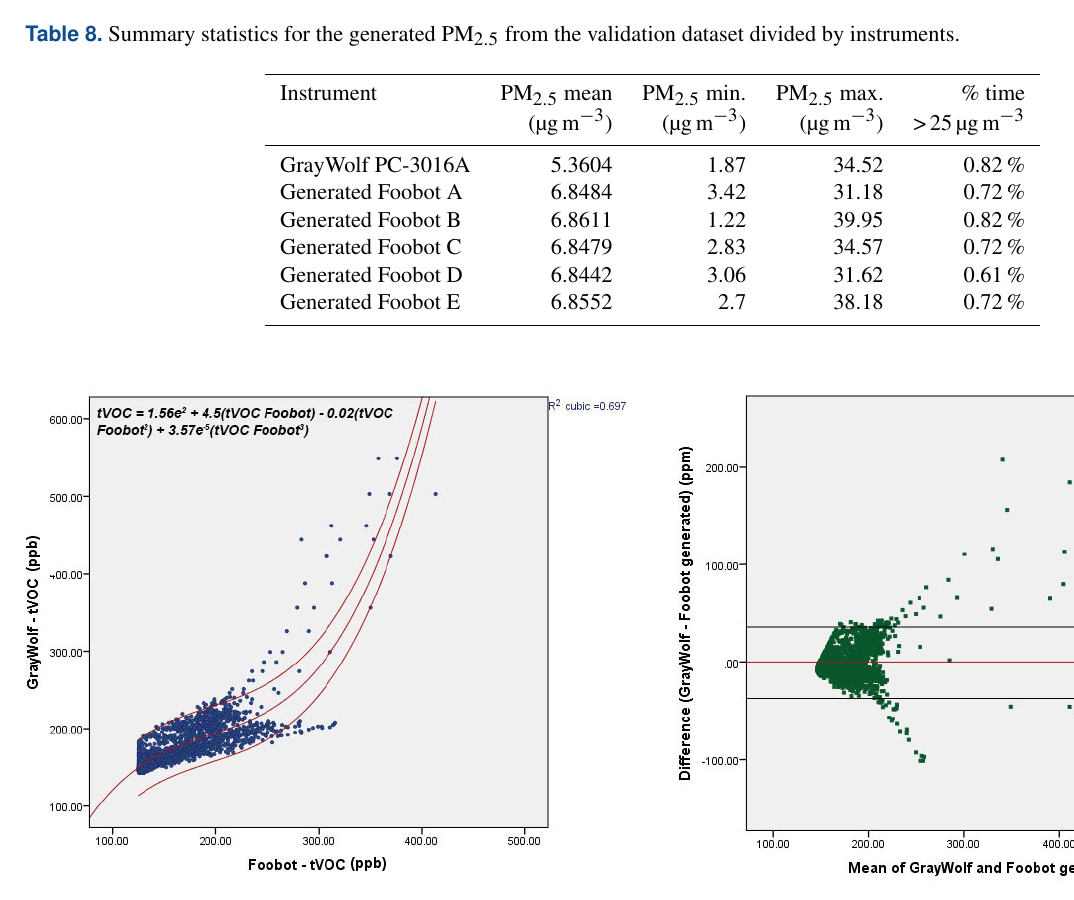
Figure 9. Bland–Altman plot of the agreement between the Gray- Wolf TG-502 TVOC and the Foobot-generated t VOC concentra-